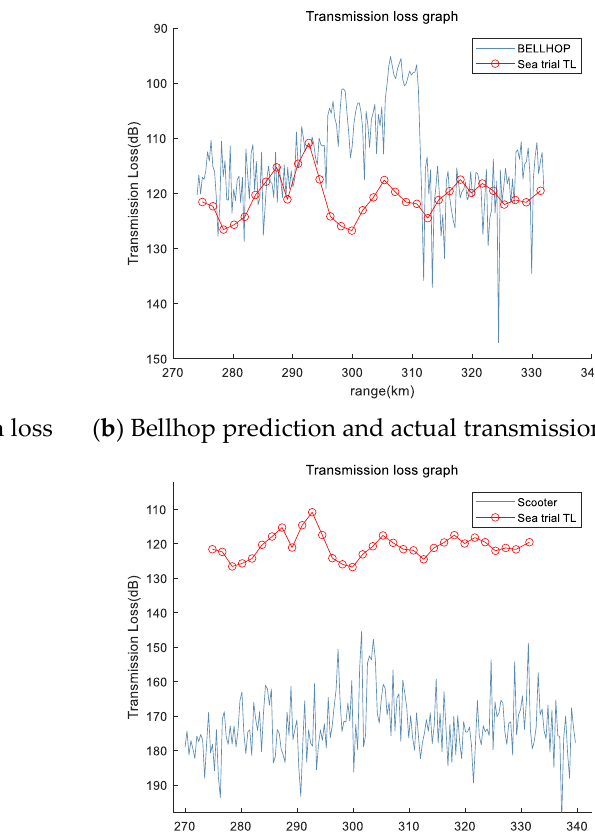
Table 5. The average RMSE error of the transmission loss data under each array element was 6.31 dB, which was the smallest error compared to other models.